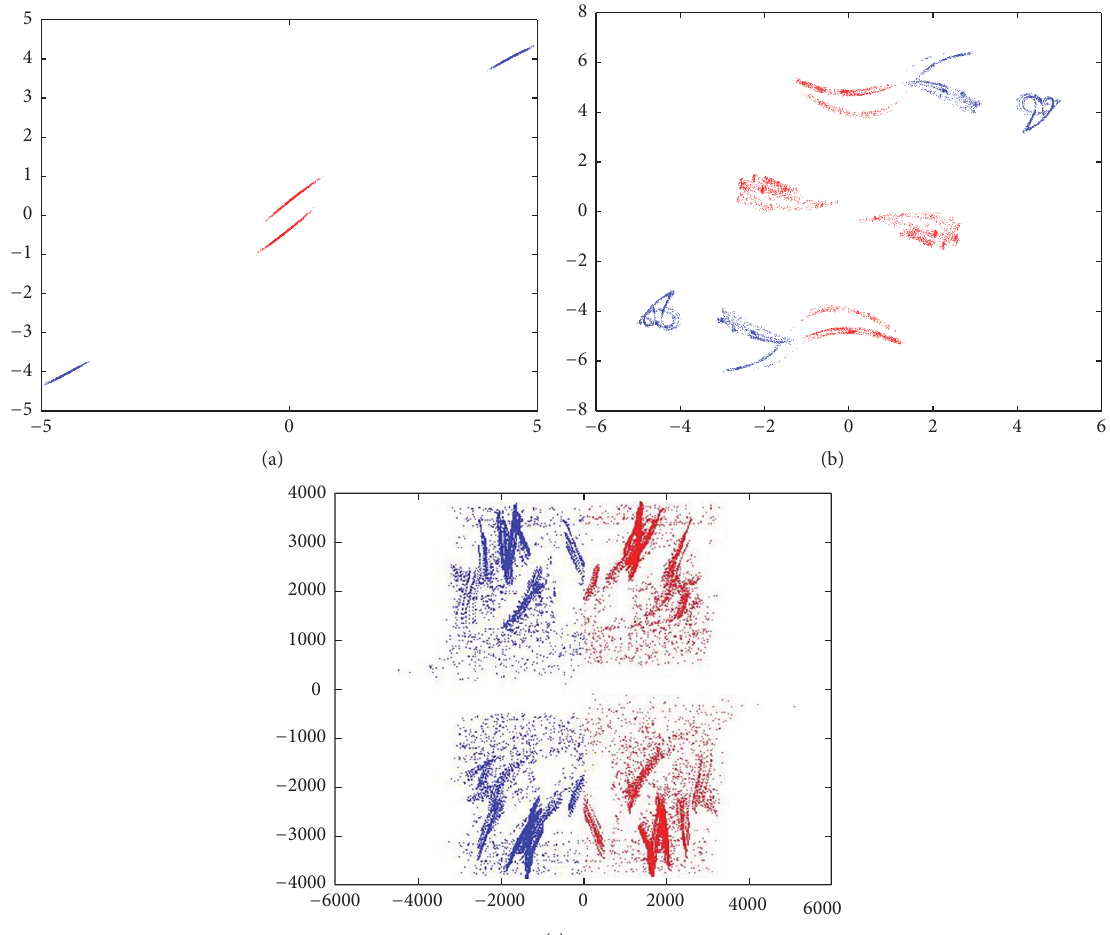
Figure 19: Poincar´e sections of the system for different 𝑎 and 𝑑 values. Red color indicates that the flow crosses the cut plane in the sense of the normal vector. Blue color indicates that the flow crosses in the opposite sense. (a) Weak chaos with initial conditions: (0.1, 0.1, 0.1, 0.1){𝑎 = 20 and 𝑑 = 10} . (b) Chaos with initial conditions: (0.1, 0.1, 0.1, 0.1){𝑎 = 38 and 𝑑 = 2} . (c) Hyperchaos with initial conditions: (−3203,−26967, 32052,−5434){𝑎 = 38.4 and 𝑑 = 2} .